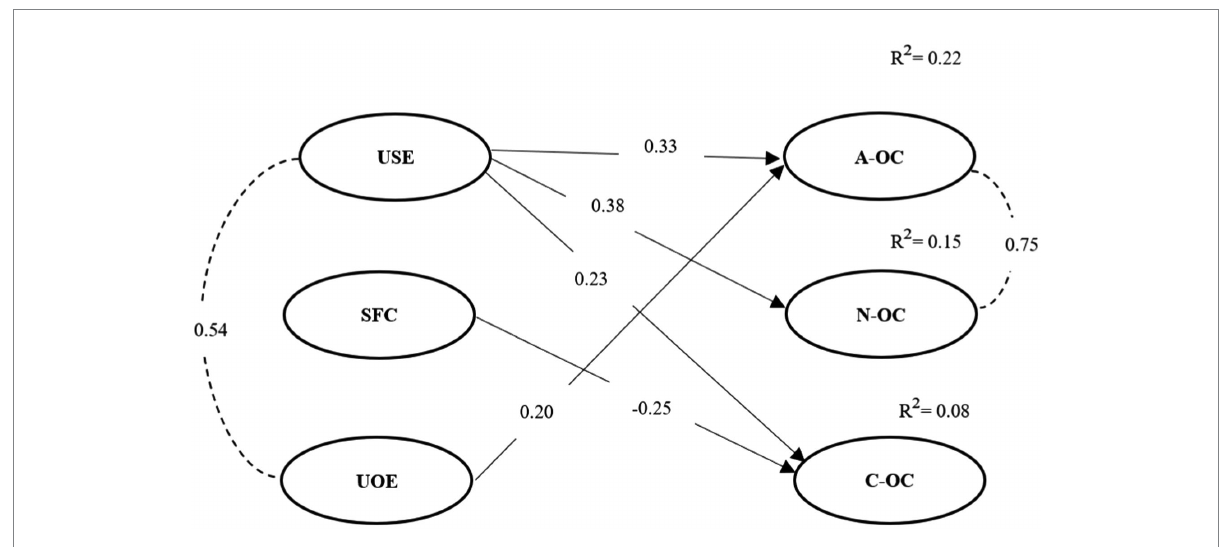
FIGURE 2 Structural model of the direct relationship between employees’ emotional awareness and organizational commitment.